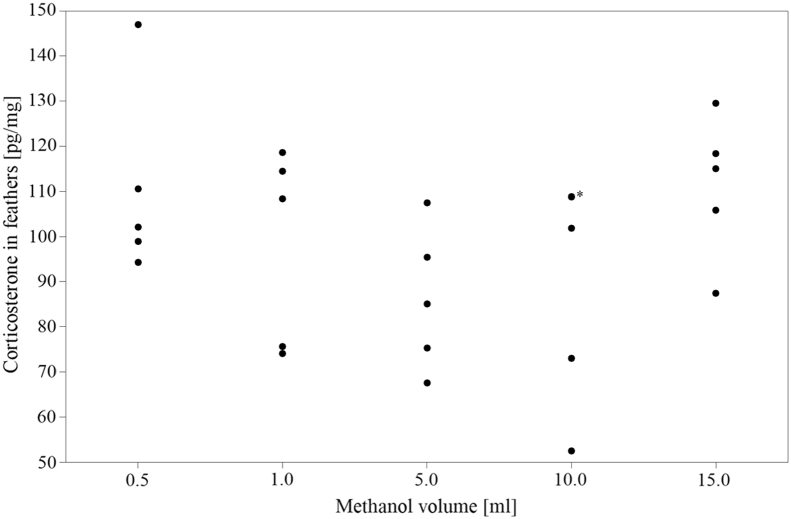
Effect of different methanol volumes (n = 5 replicates each group; ∗: 2 values, 108.9 pg/mg and 108.8 pg/mg, are overlapping).